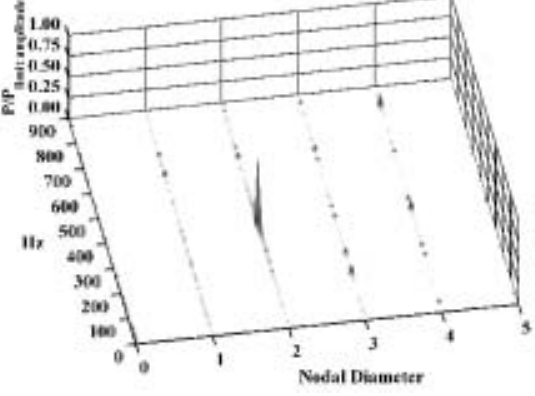
Fig. 16. Two-dimensional Fourier transform of pressure transducer data at 13 seconds.